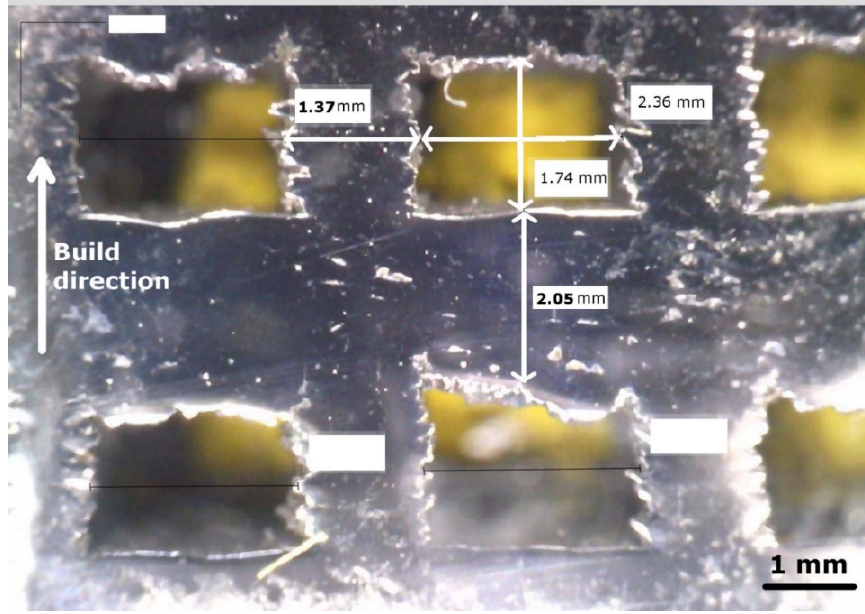
Figure 5. Macro image of 1.5 mm vertical struts produced using the standard scan strategy (cross-section along the Z -direction).